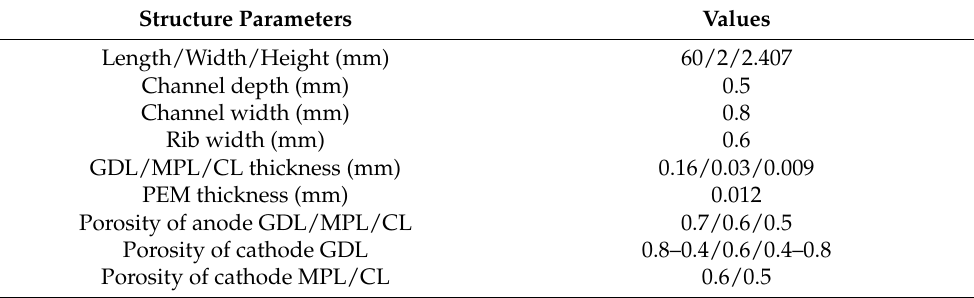
Table 1. Parameters of the geometric model. Structure